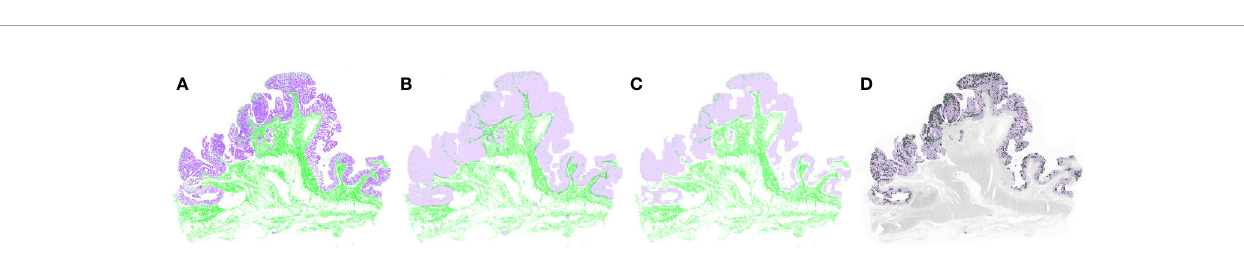
FIGURE 3 | Tumor and peri-tumoral stroma (PTS) segmentation after applying morphological image processing. (A) The model extracted the tumor and stromal portion from the whole-slide image. After the morphological dilation (B) and erosion operations (C) , the PTS area was segmented (D) . Purple represents tumor, and green represents